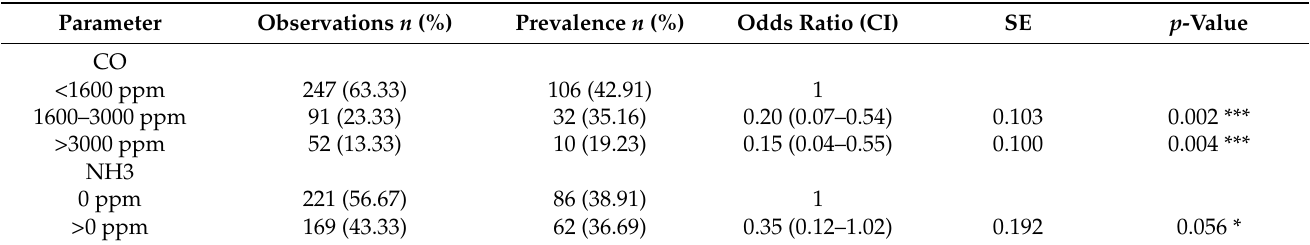
Table 6. Welfare indicators’ prevalence (including mortality) by different CO 2 and NH 3